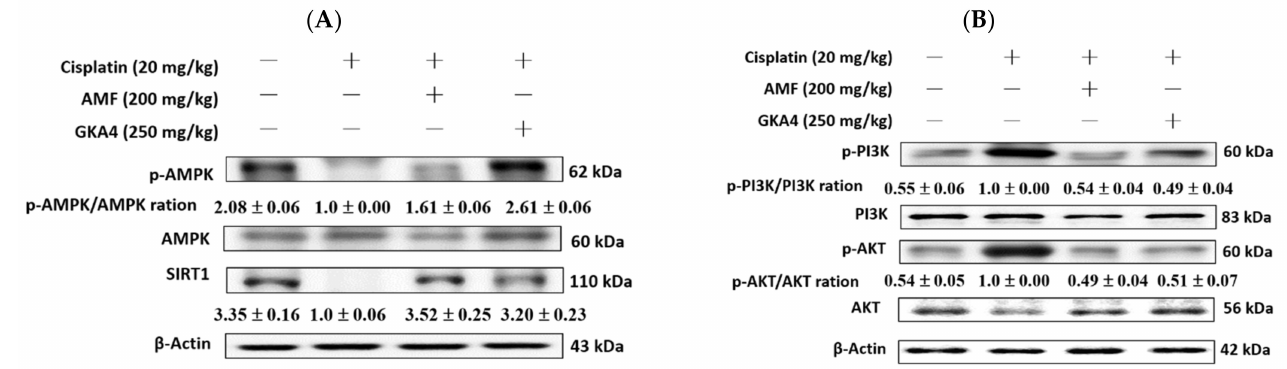
Figure 6. GKA4 regulated AMPK, SIRT1, PI3K, and AKT protein expression in cisplatin-induced AKI mice. Kidney tissue lysate was subjected to western blot analysis using antibodies specific to AMPK, p-AMPK SIRT1, PI3K, p-PI3K, AKT, and p-AKT. GKA4 regulated AMPK/SIRT1 signal ( A ) and PI3K/AKT signal pathway ( B ). Protein bands were analyzed by densitometric analysis. Experiments were performed at least three times, and representative images are shown. Plus signs: with drug; Minus signs: without drug.